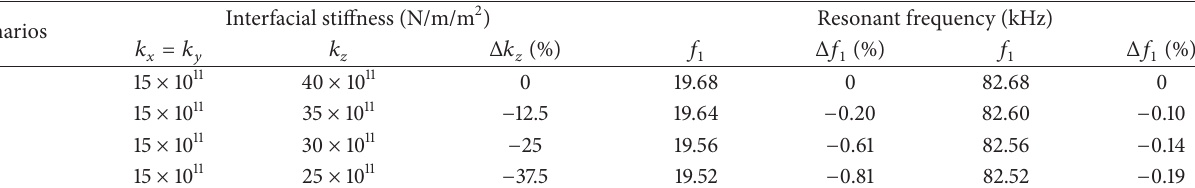
Table 3: Interfacial stiffness versus resonant frequency.